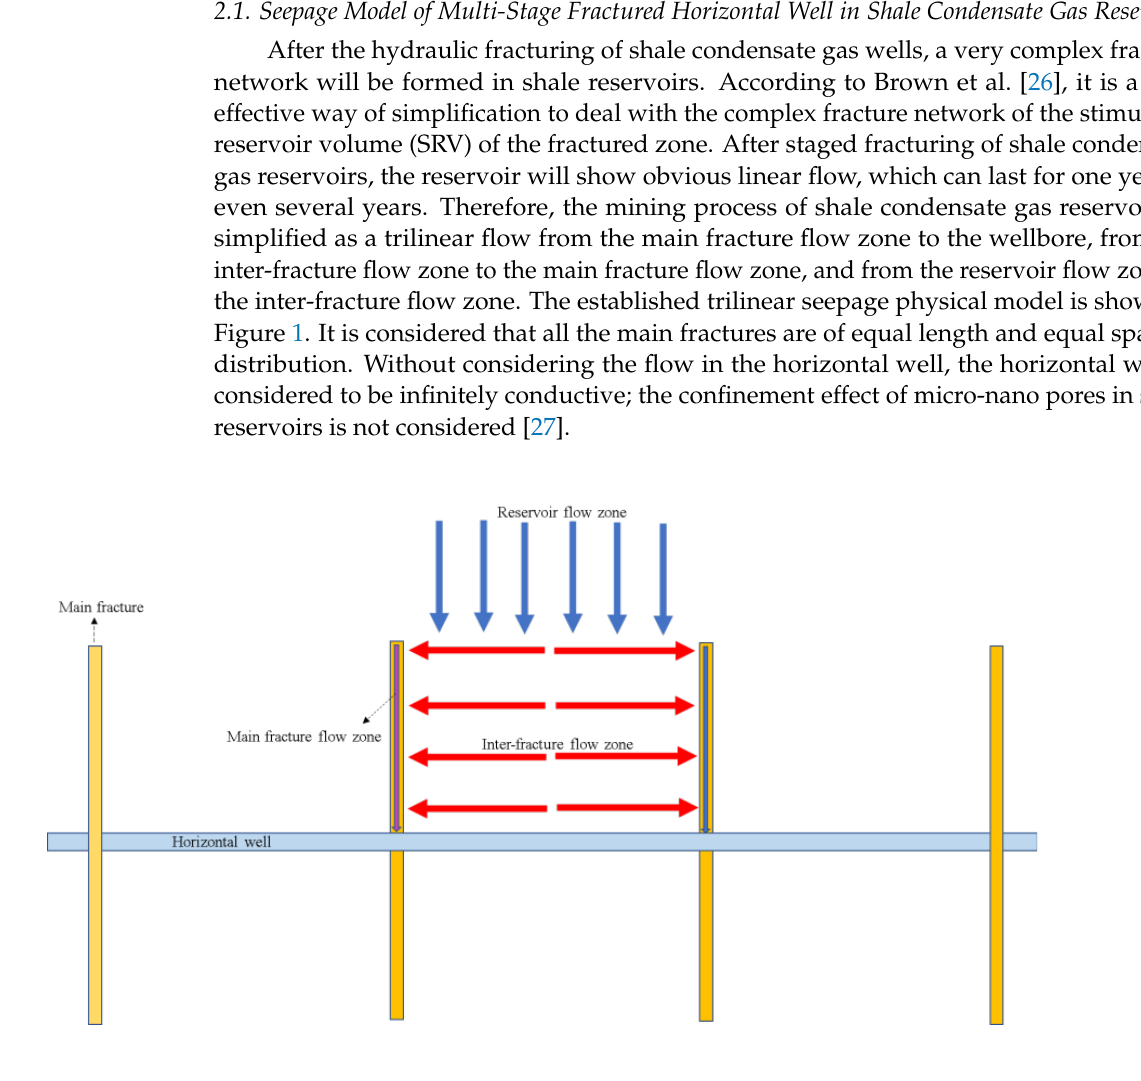
Figure 1. Trilinear seepage physical model of staged fracturing horizontal wells in shale condensate gas